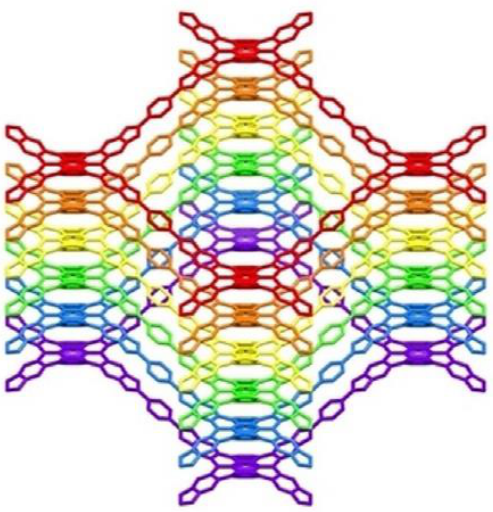
Figure 5. The structure 3D COF-HBC with pcu topology [23].